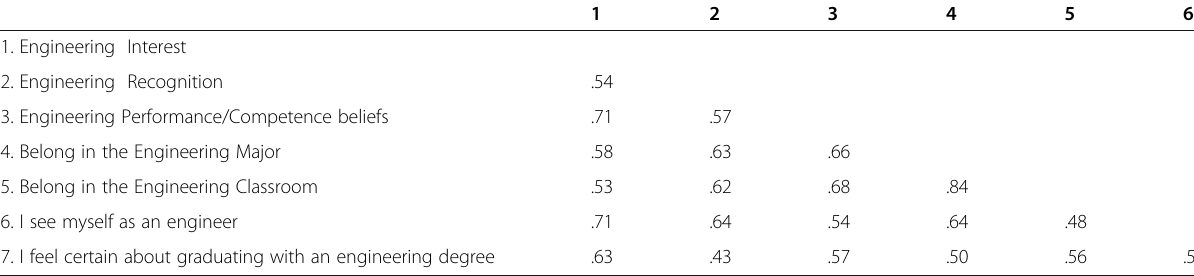
Table 3 Correlation coefficients of latent constructs and single